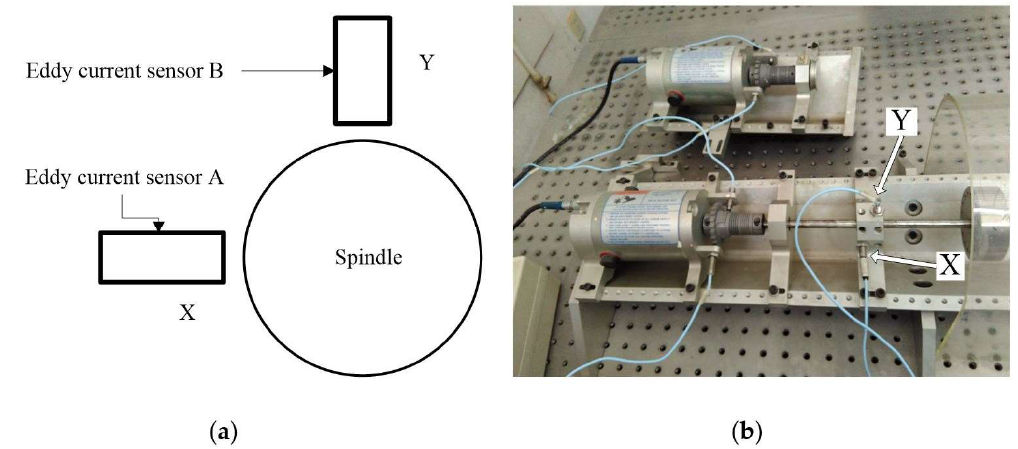
Figure 22. The experimental facilities. ( a ) The arrangement of the eddy current sensors; ( b ) The experimental setup.